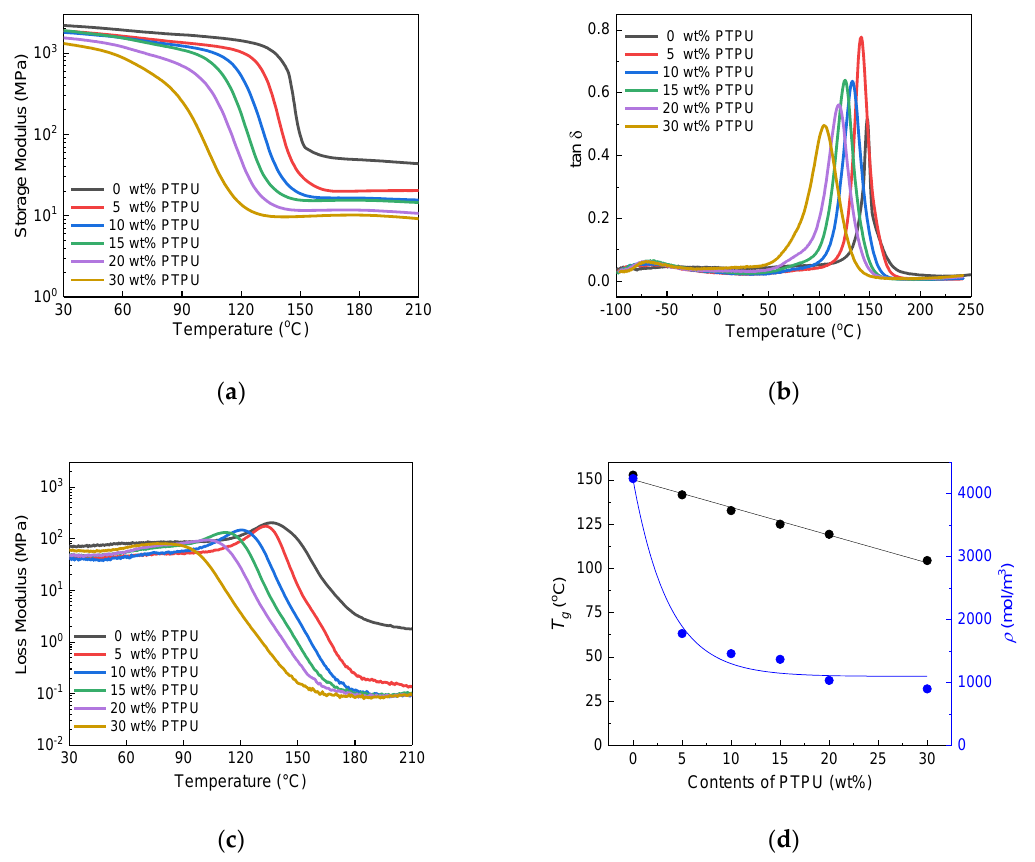
Figure 3. Storage modulus ( a ), loss tan δ ( b ), and loss modulus ( c ) curves of the PTPU-toughened epoxy adhesives and their T g and crosslink densities ( d ) as a function of the PTPU content.